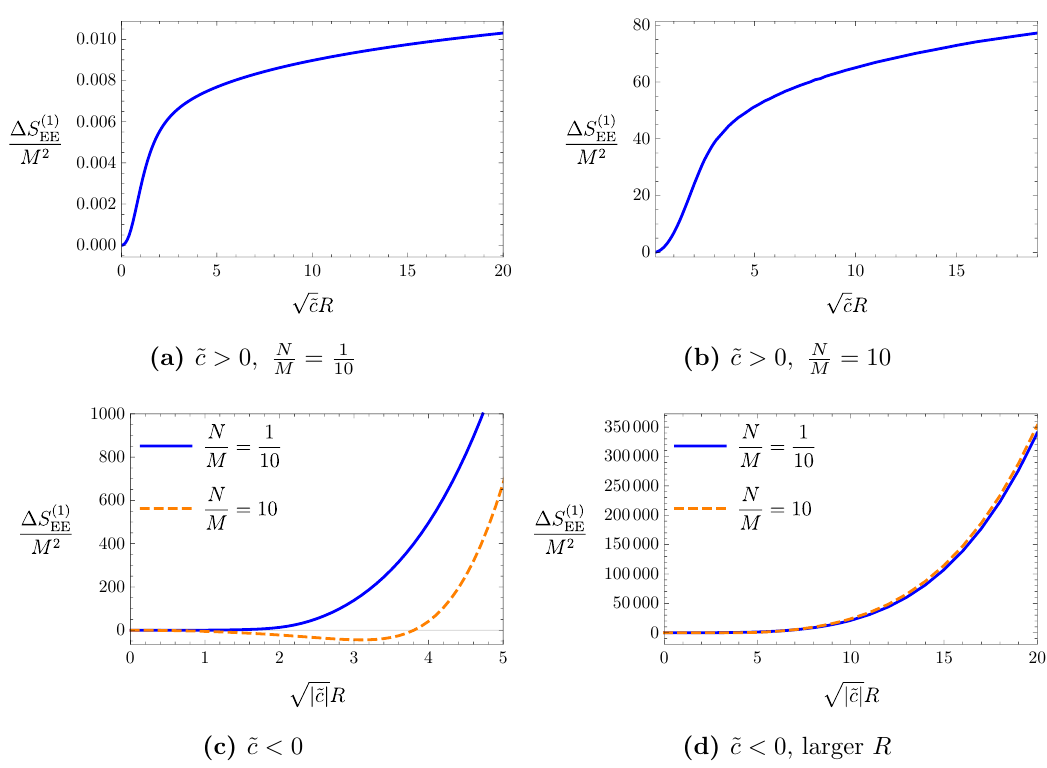
Figure 6. The defect contribution to entanglement entropy as a function of the radius R